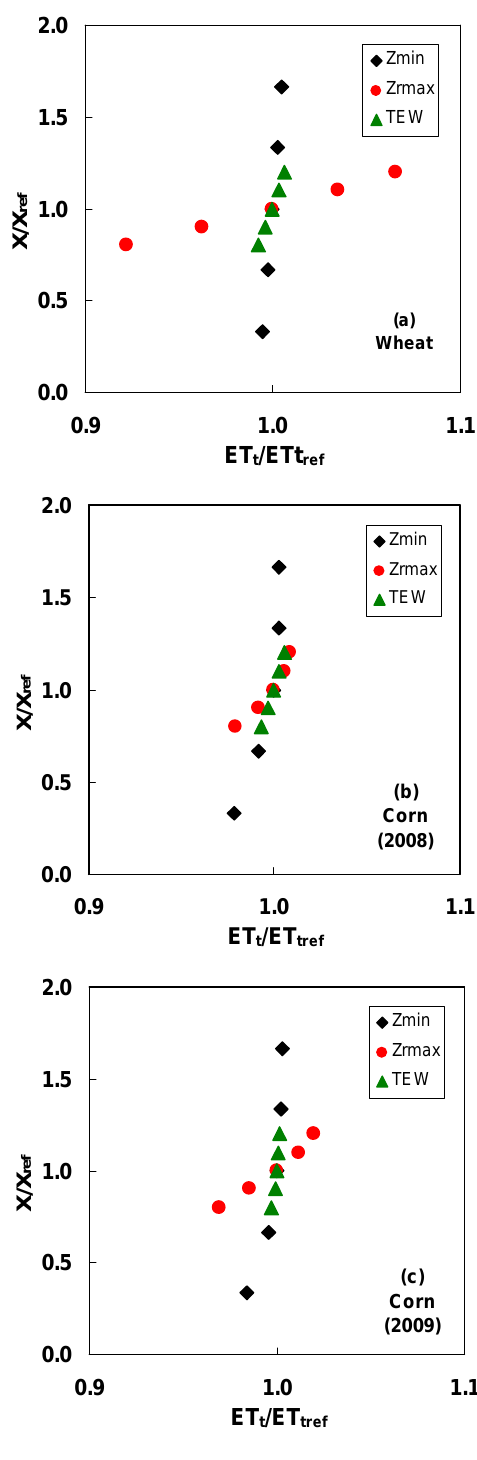
Fig. 8. ET t with respect to ET tref for variations in maximum effec- tive root depth ( Z max ) , minimum effective root depth (Z min ) and TEW, for wheat 2009 season (a) and corn 2008 (b) and 2009 (c) seasons.